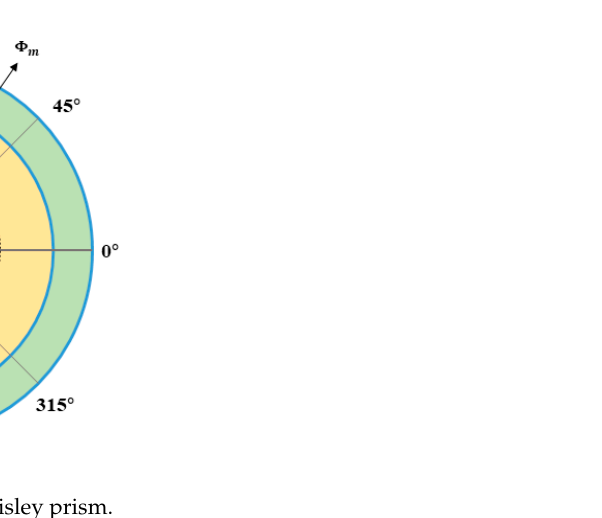
Figure 2. Field distribution of a Risley prism.